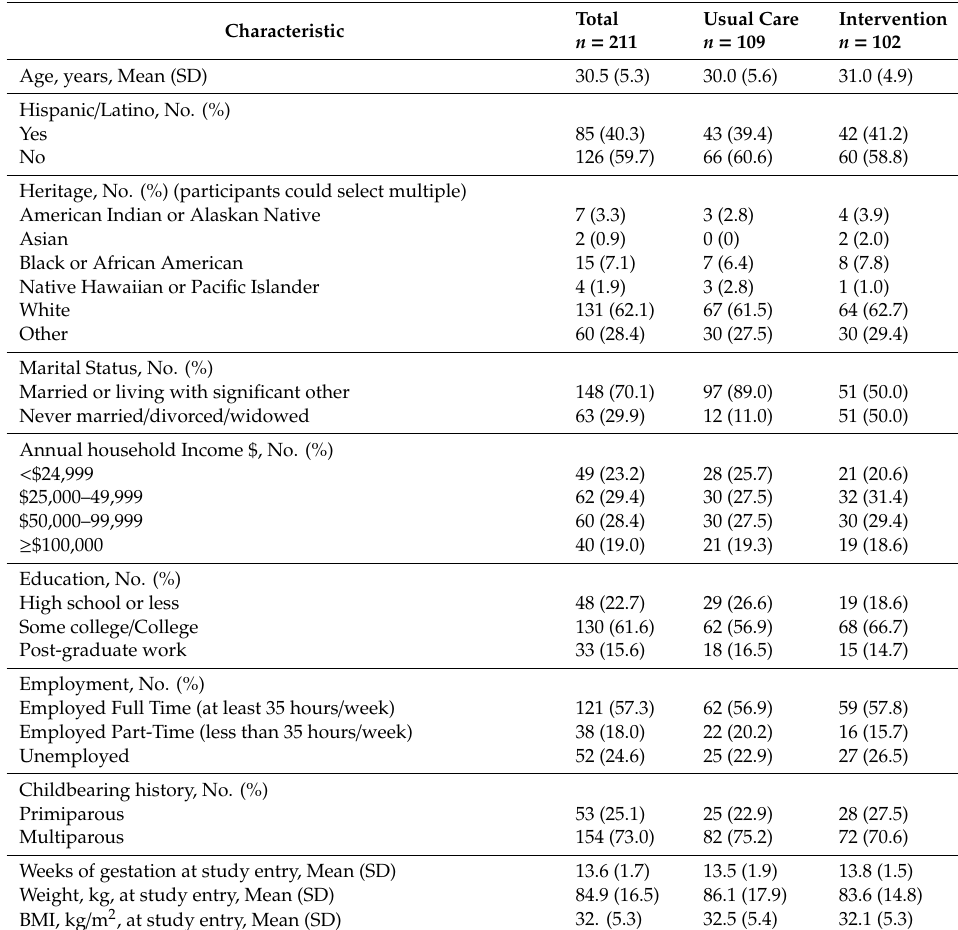
Table 2. Baseline characteristics of the participants by